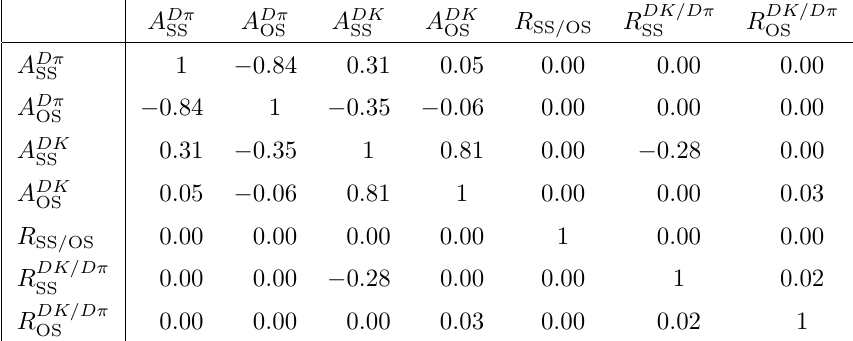
K (cid:3) (892) (cid:6) region (cid:12)t. (cid:0)